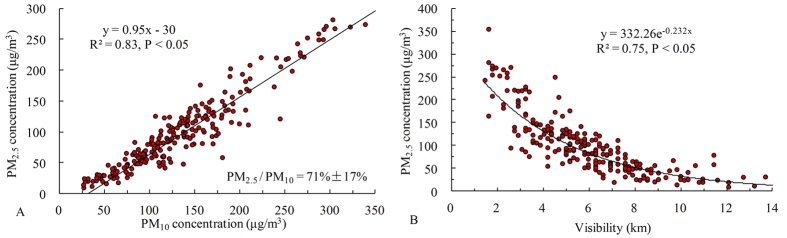
Proportion of PM2.5 in PM10 (A) and relationship between PM2.5 concentration and visibility (B) on stable meteorological days.